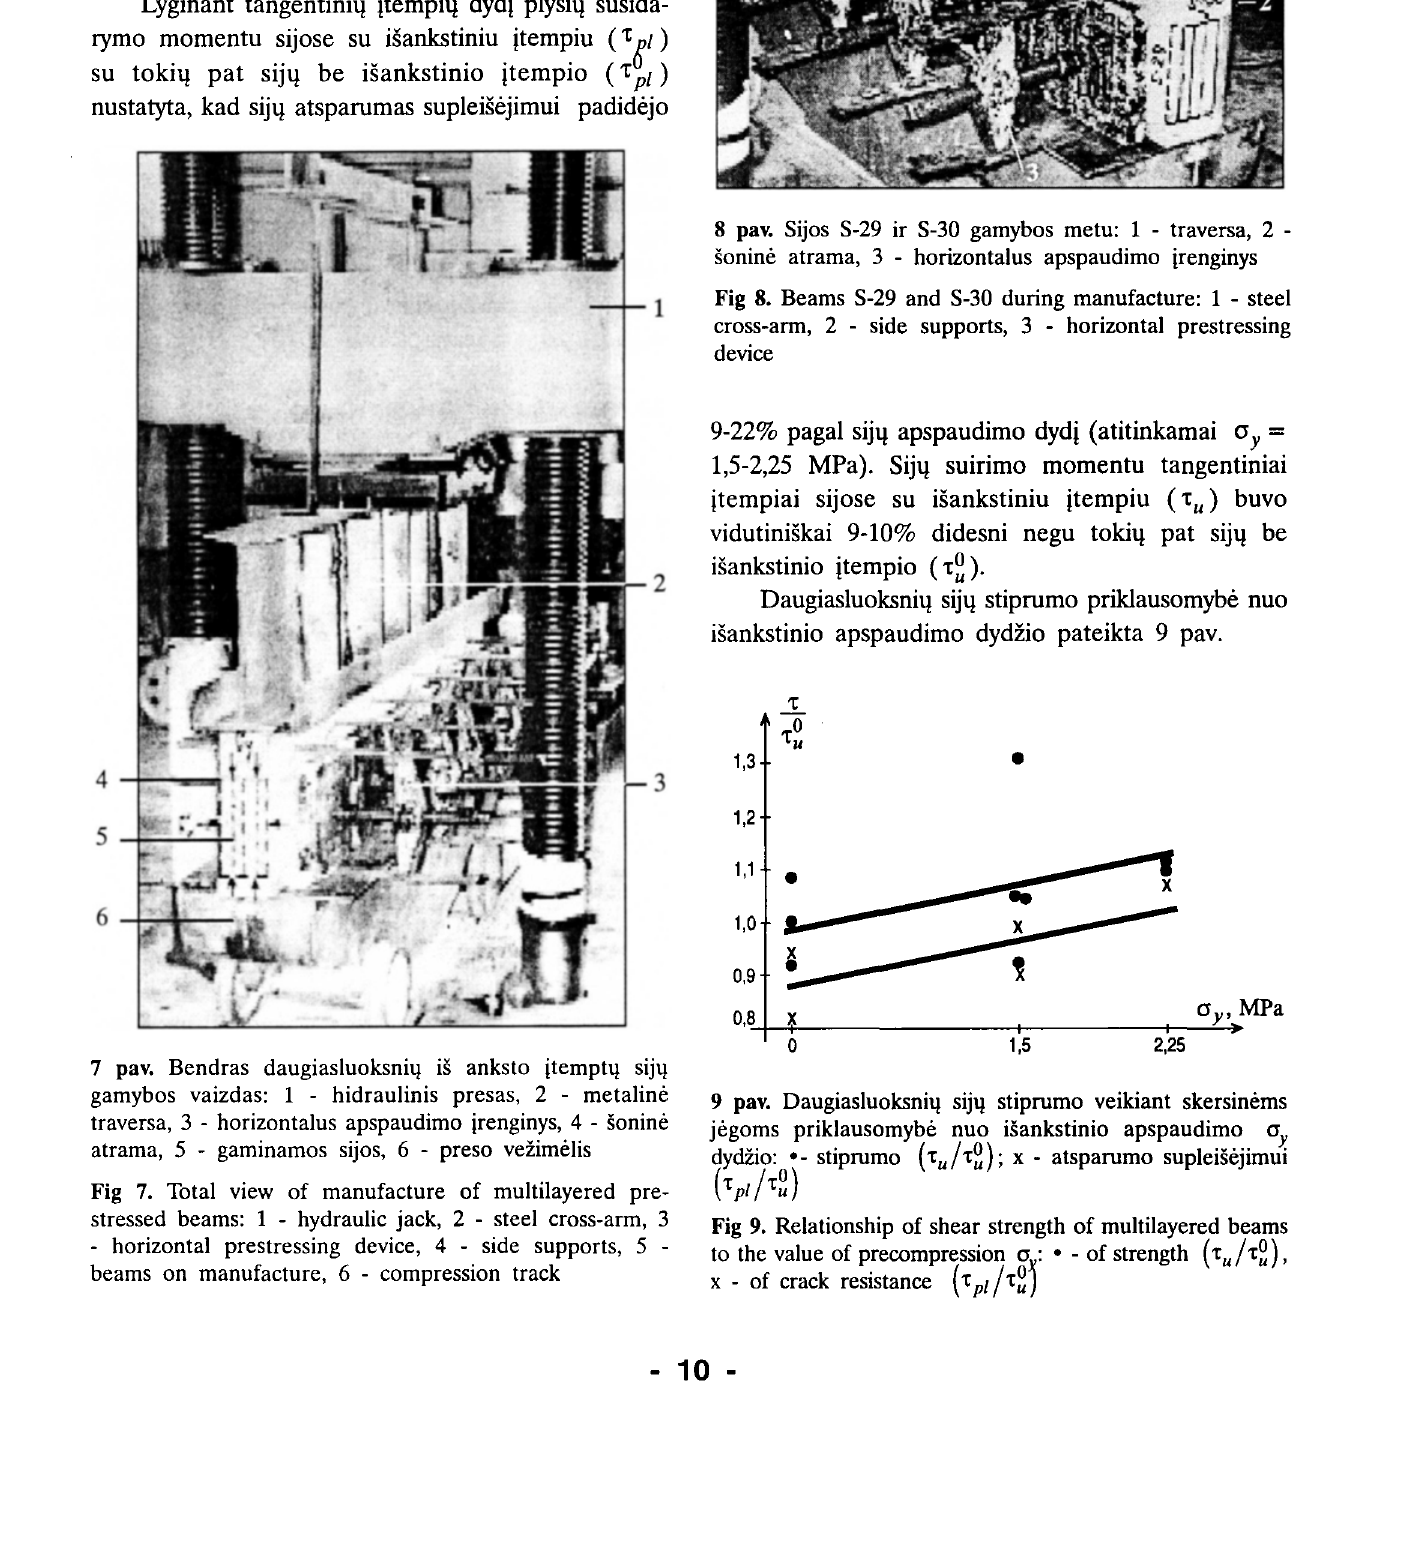
Fig 9. Relationship of shear strength of multilayered beams I -r2) , to the value of precompression ax: • - of strength ( -r u Pt/ 't~ x - of crack resistance { 't